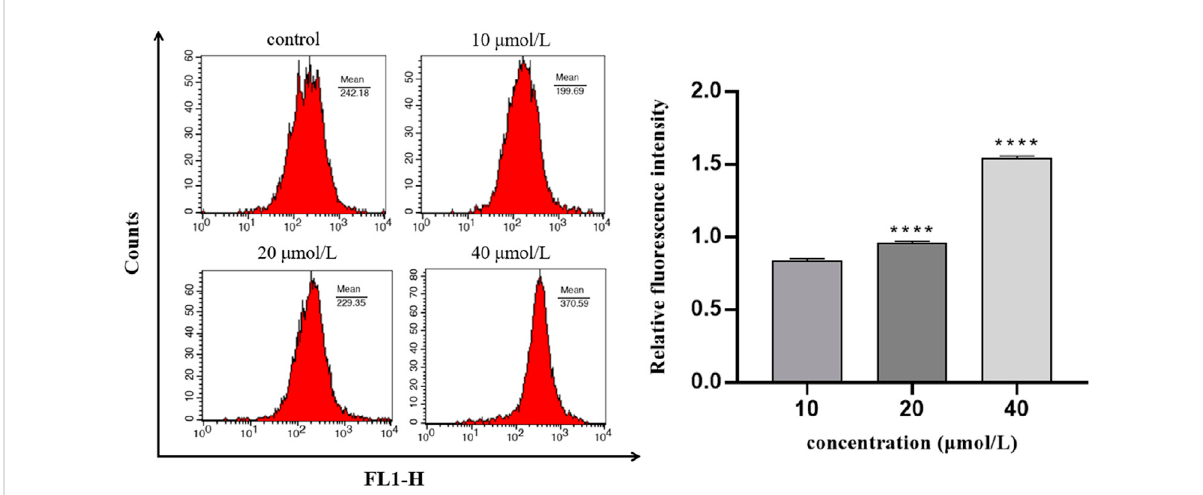
Theconcentrationofintracellularcalciumin786-OcellsinducedbyRFA.Therelativelevelofintracellularcalciumwasshownastheratioofthe fl uorescence intensity of the treated group to the blank group. Data were expressed as mean ± SD. t -test was used for the statistical analysis of results. **** p < 0.0001, versus the low concentration group (10 μ mol/L).